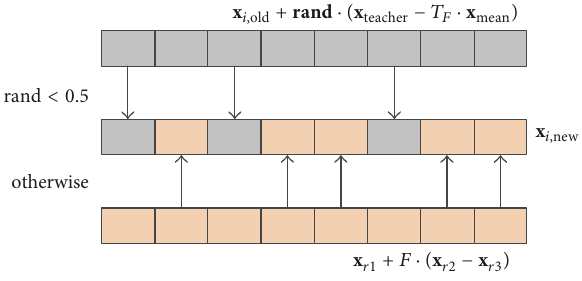
Figure 2: Diversity enhanced teaching